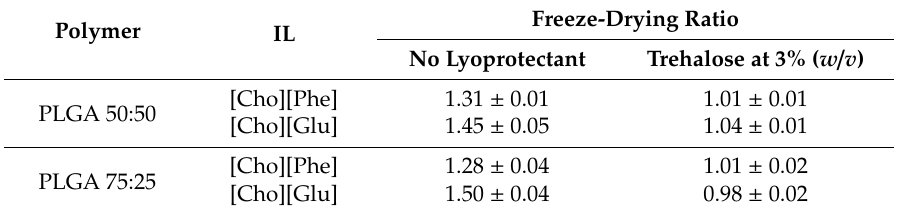
Table 1. Freeze-drying ratio for the rutin-loaded IL-polymer nanoparticle hybrid systems, in the presence and in the absence of trehalose results, obtained from Equation (2). Data represented as mean ± SD ( n =